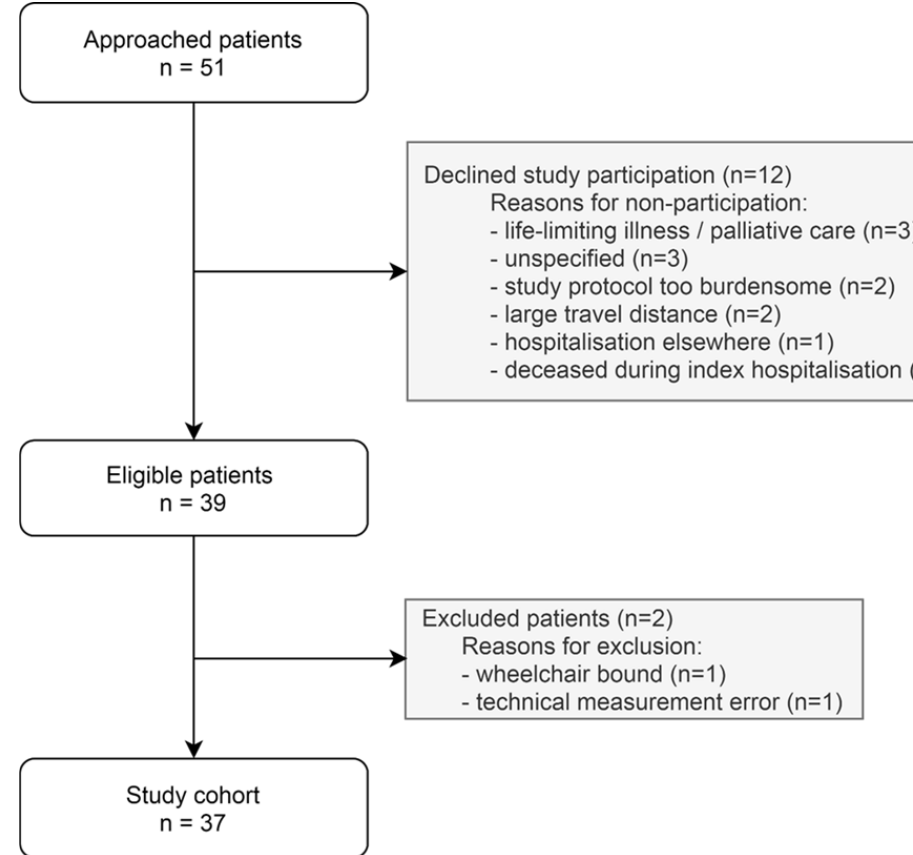
Figure 1. Flowchart of the study population. Table 1. Patient